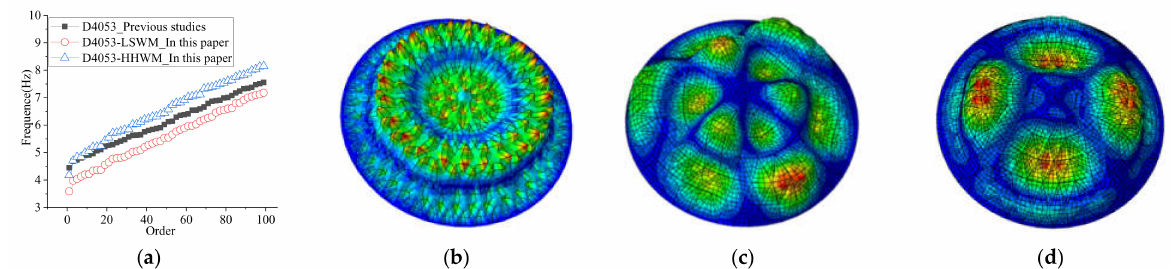
Figure 3. Comparisons of the finite element analysis methods in the previous studies and this paper: ( a ) the first 100 frequencies; ( b ) the 8th order mode for D4053 in previous studies; ( c ) the 8th order mode for D4053-LSWM in this paper; ( d ) the 8th order mode for D4053-HHWM in this paper.